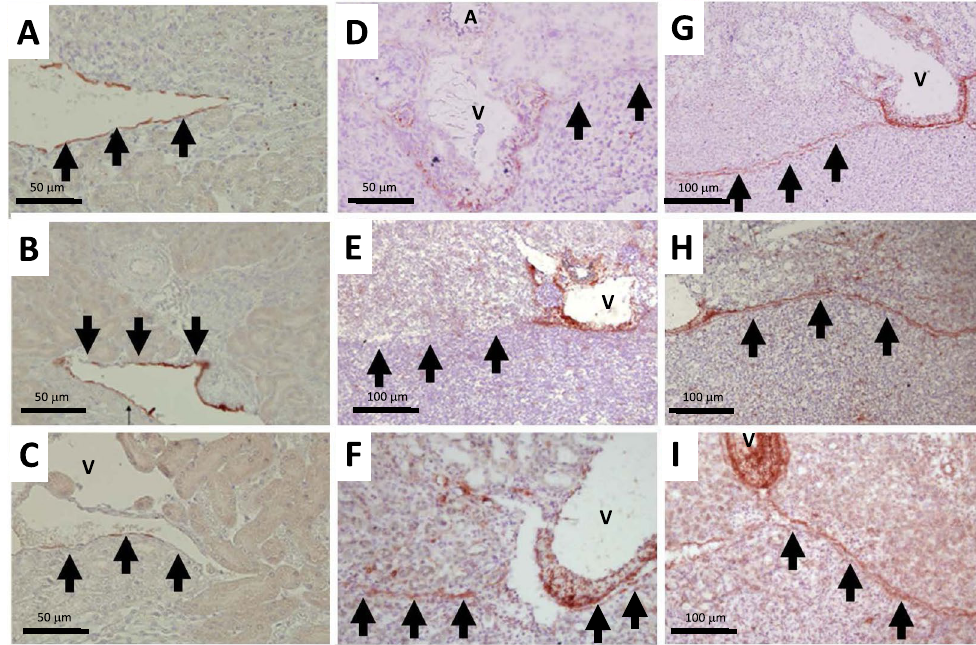
Figure 5. Urothelial phenotype modification during the study. ( A – C ) : Expression of UPIII positive cells in control group ( A ), HLP group on day 21 ( B ), and HLP + FGF7 group on day 21 ( C ). ( D – I ): Expression of CD44 positive cells in control group ( D ), HLP group on day 21 ( E ) and 42 ( F ), 2 days after FGF7 administration (G), HLP + FGF7 group at days 21 ( H ) and 42 ( I ). Paraffin embedded ( A – C ) and frozen ( D – I ) sections. Positive CD44 cells in the interstitium near interlobar veins (V) are macrophages. Black arrows indicate urothelial cells surrounding urinary spaces which are collapsed in frozen tissue sections ( A – C ) and open in paraffin-embedded ( D – I ) kidney sections. A = artery. V = vein.